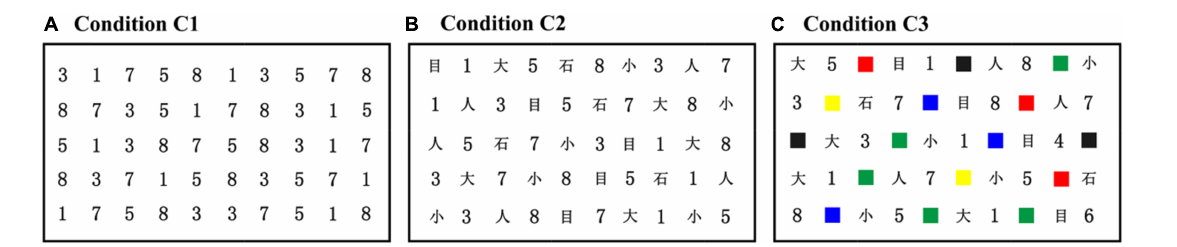
FIGURE1 The C-RAN paradigm presented a 5 × 10 matrix of stimuli (e.g., numbers, Chinese characters, or colors) in different conditions. (A) Condition C1 (i.e., naming a series of numbers sequentially); (B) condition C2 (i.e., naming a series of numbers and Chinese characters sequentially); and (C) condition C3 (i.e., naming a series of numbers, Chinese characters, and colors sequentially). RAN, rapid